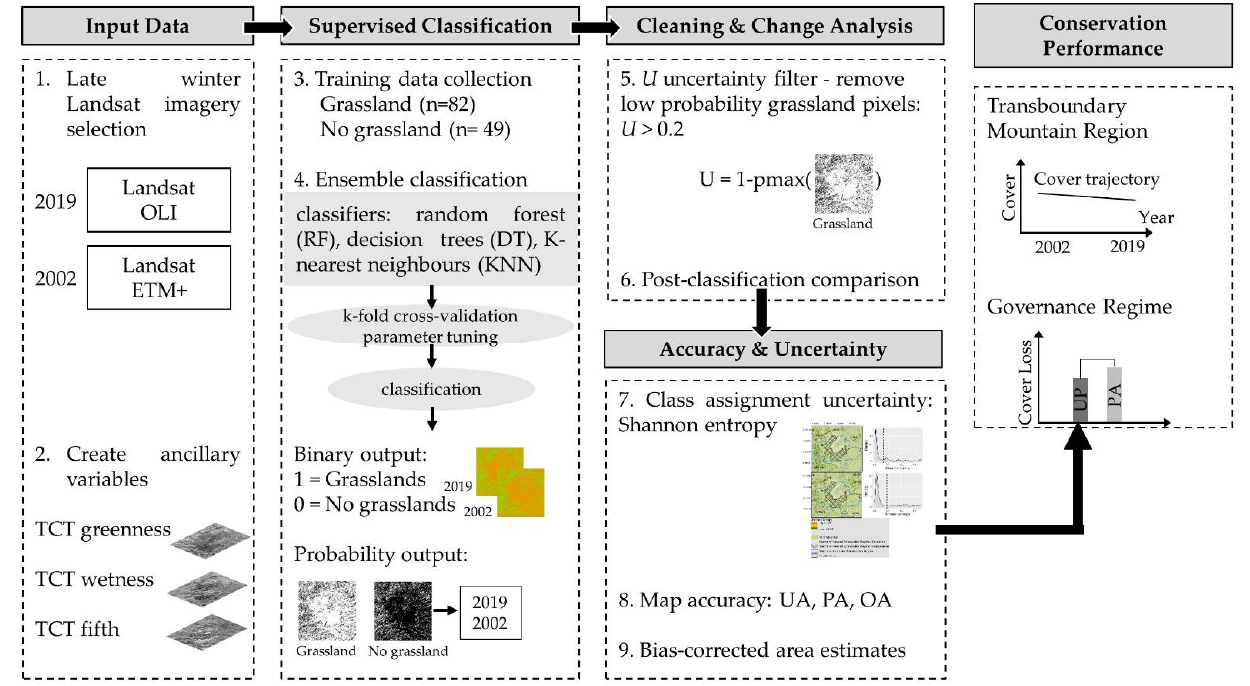
Figure 2. Overall research methodology workflow.